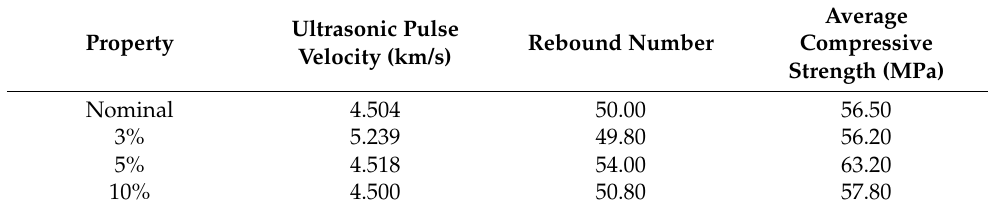
Table 6. Non-destructive testing